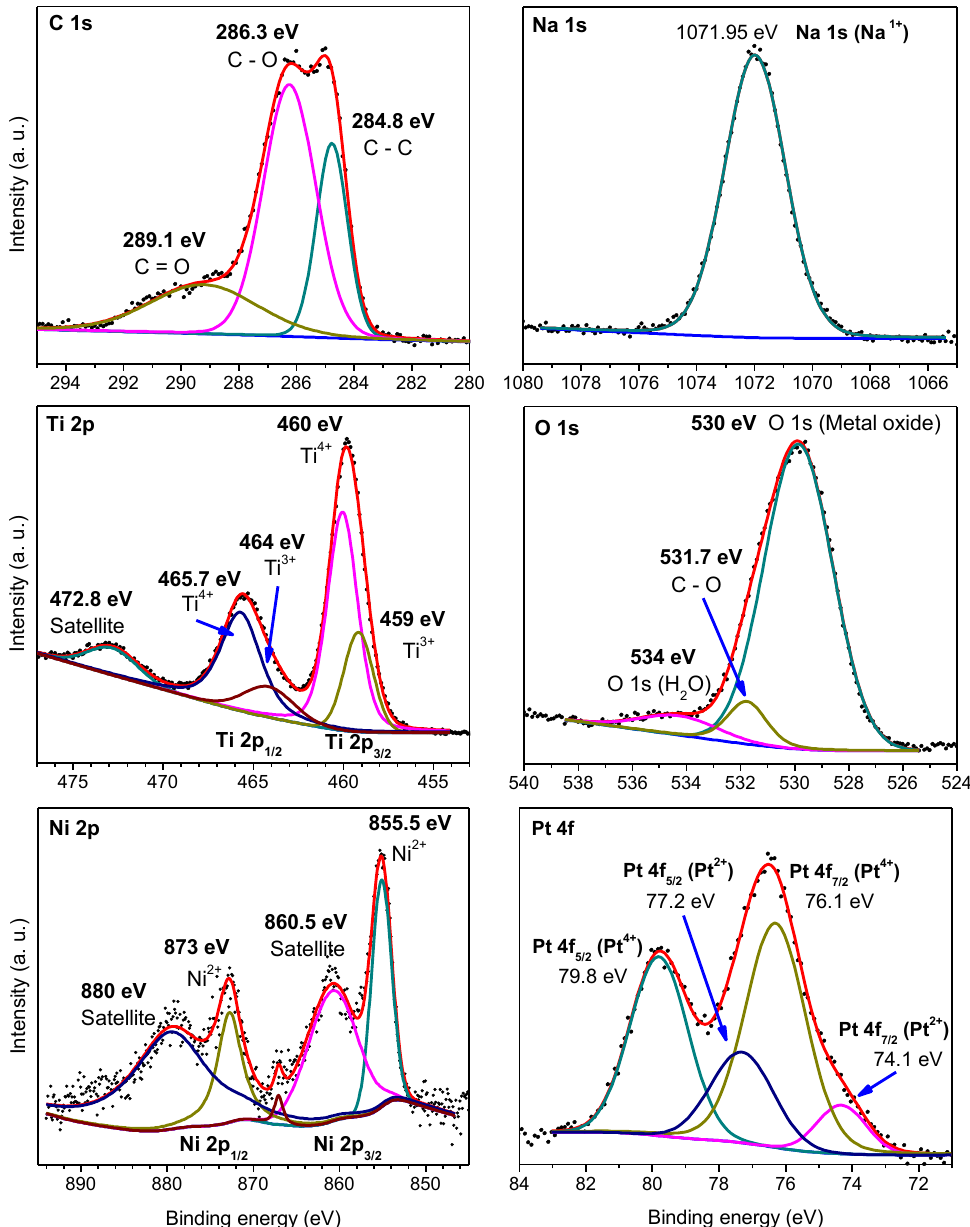
Figure 3. XPS spectra in C 1s, Ti 2p, Na 1s, O 1s, Ni 2p, and Pt 4f zones of the NTO/Ni/Pt sample.